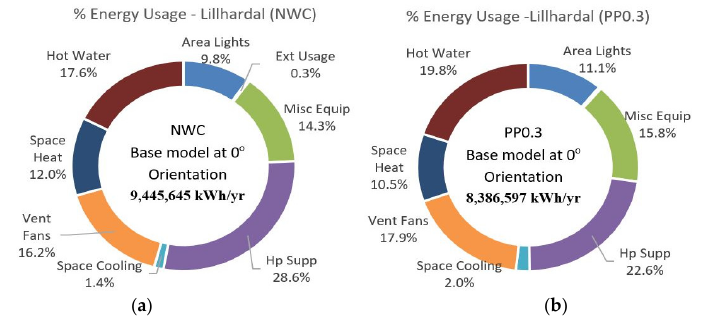
Figure 9. Comparison of percentage breakdown of annual energy consumption end-use comparison for Lillhardal: ( a ) NWC; ( b ) PP0.3. for Lillhardal: ( a ) NWC; ( b )